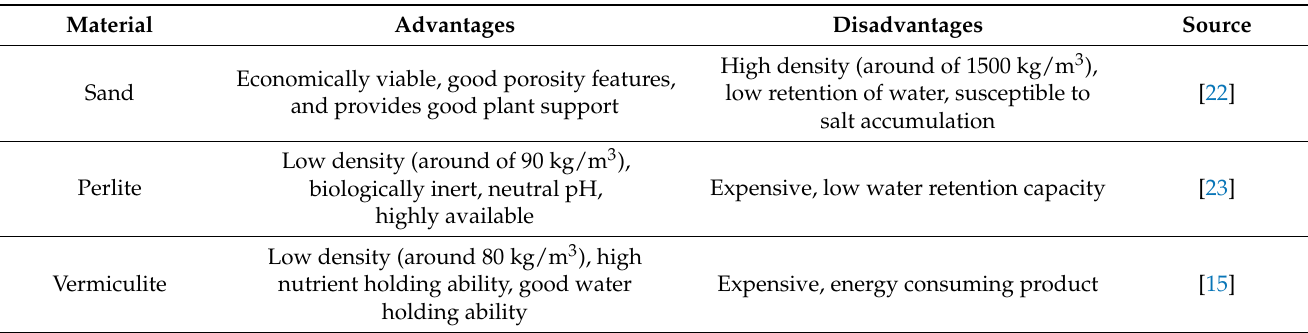
Table 1. Main substrates used in